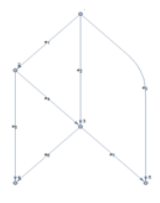
Figure 1. Network with a sourse and two